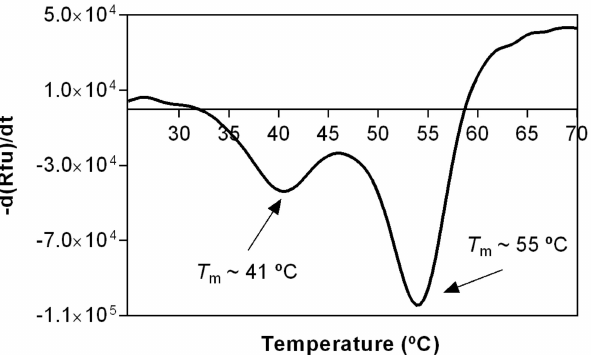
Figure 3. TSA melting curve of STEAP1 obtained from thermal stability fluorescence data of first derivative (d(Rfu)/dt) curves in 10 mM Tris-HCl, pH 7.8 buffer exhibiting a T m of 41 and 55 ◦